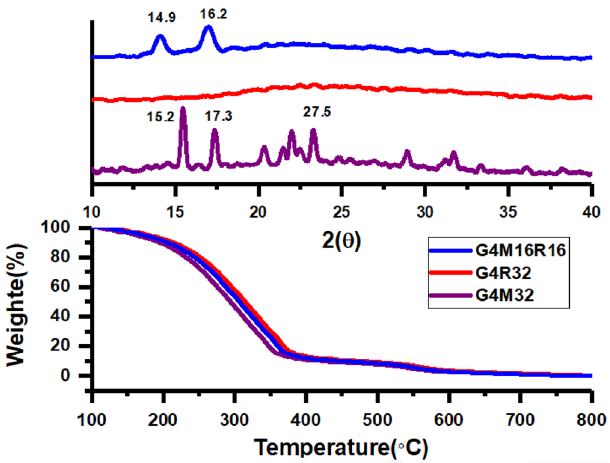
Figure 1. TGA thermograms and XRD patterns of various